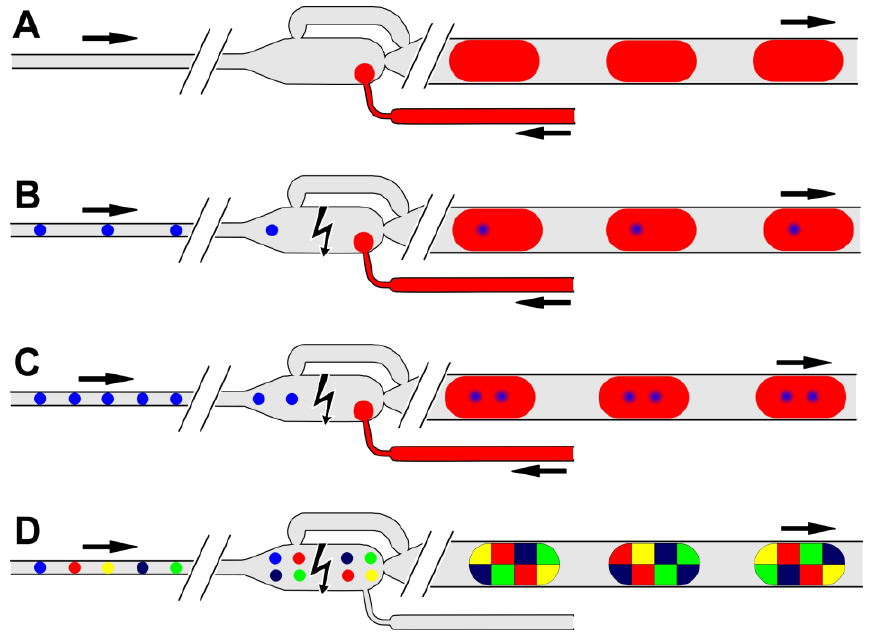
Figure 2. Schematic operation modes of the bypassed chamber: ( A ) Self-controlled droplet formation mode. The dispersed phase (red) is embedded by the carrier phase (gray). Droplet volume is defined by the chamber geometry. ( B ) Single droplet dilution mode. A single droplet (blue) is delivered into the chamber and diluted by coalescence with the diluting media (red). The pulsed electrocoalescence voltage is permanently on. ( C ) Multiple droplets dilution mode. Two—or even more—initial droplets (blue) are delivered into the chamber and diluted by coalescence with the diluting media (red). The pulsed electrocoalescence voltage is permanently on. ( D ) Multiple droplet coalescence mode. The chamber is filled with a defined number of droplets (colored) which are merged by periodically triggered electrocoalescence.